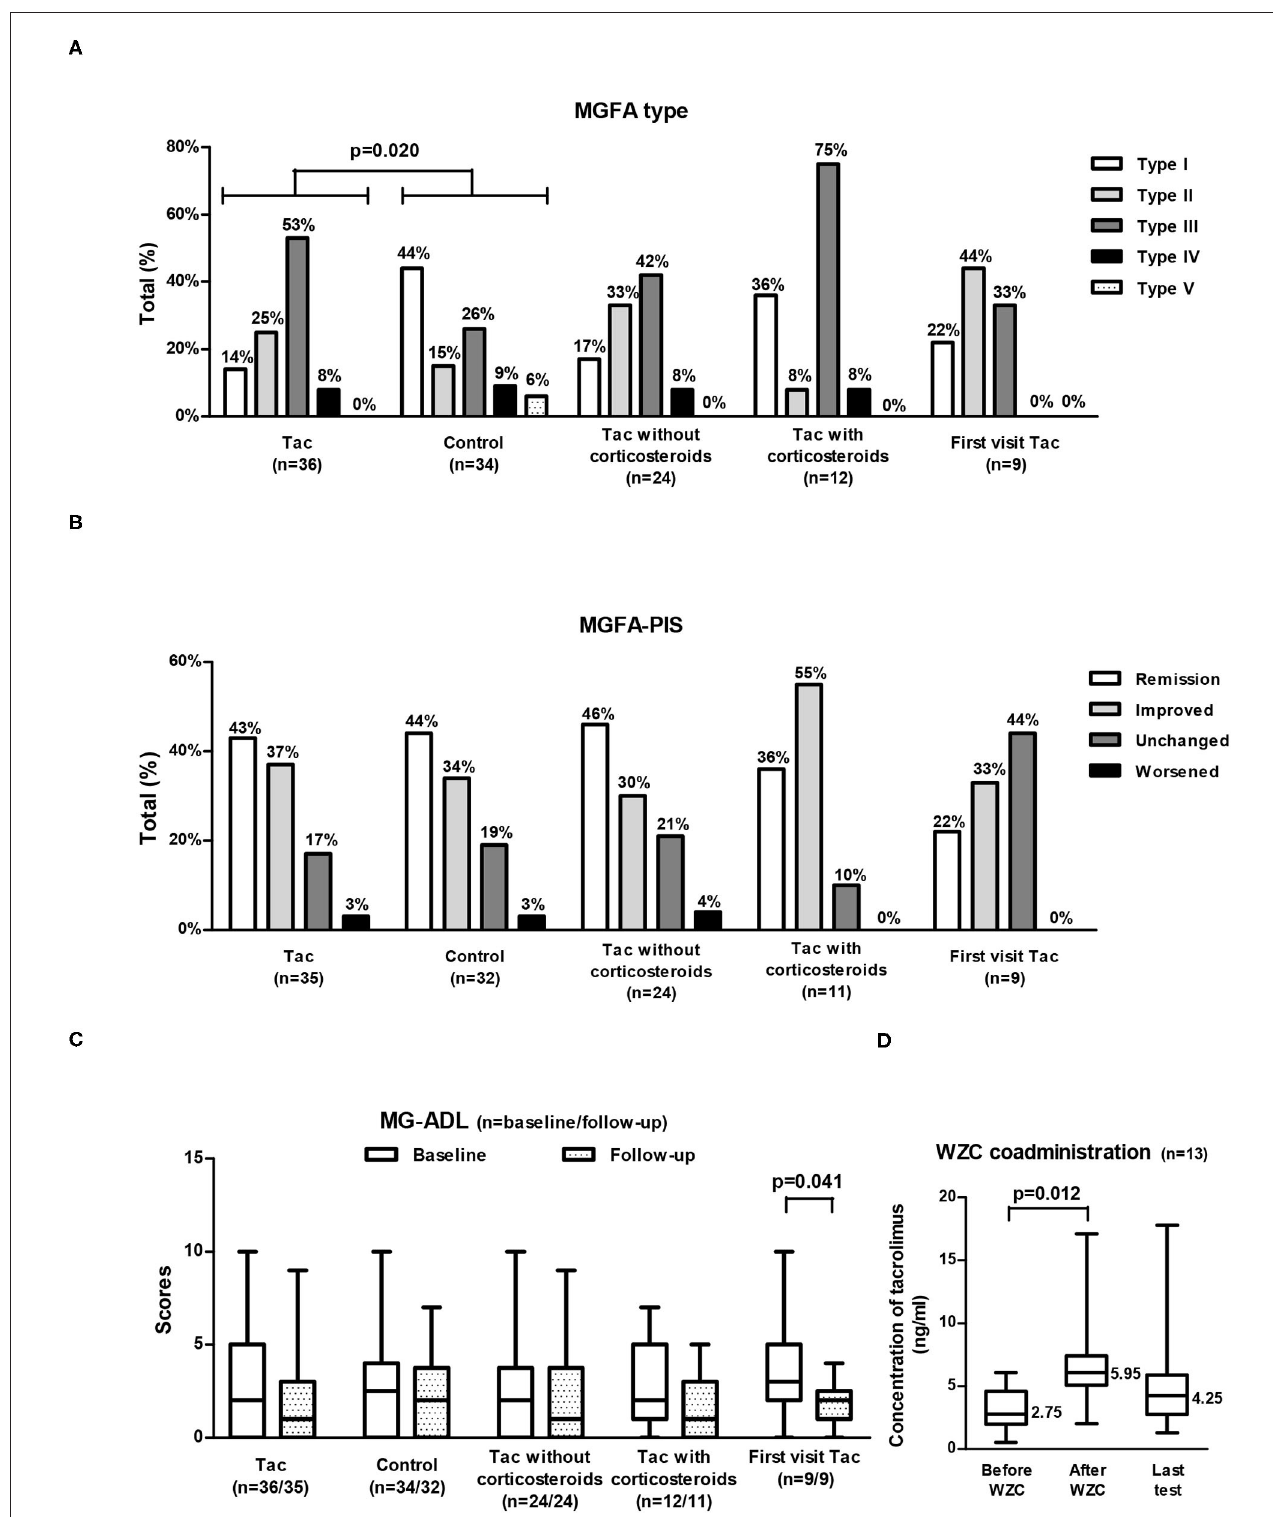
FIGURE 2 | MGFA type (A) , MGFA-PIS at follow-up (B) , and MG-ADL (C) in different groups of VLOMG patients and changes in tacrolimus concentrations with WZC coadministration (D) . MGFA type and baseline MG-ADL shared the same sample size of each group [as displayed in (A,C) ]; MGFA-PIS and MG-ADL at follow-up were not available for the three deceased patients and they also shared the sample size presented in (B,C) . A total of 13 patients coadministrated WZC (D) . VLOMG,